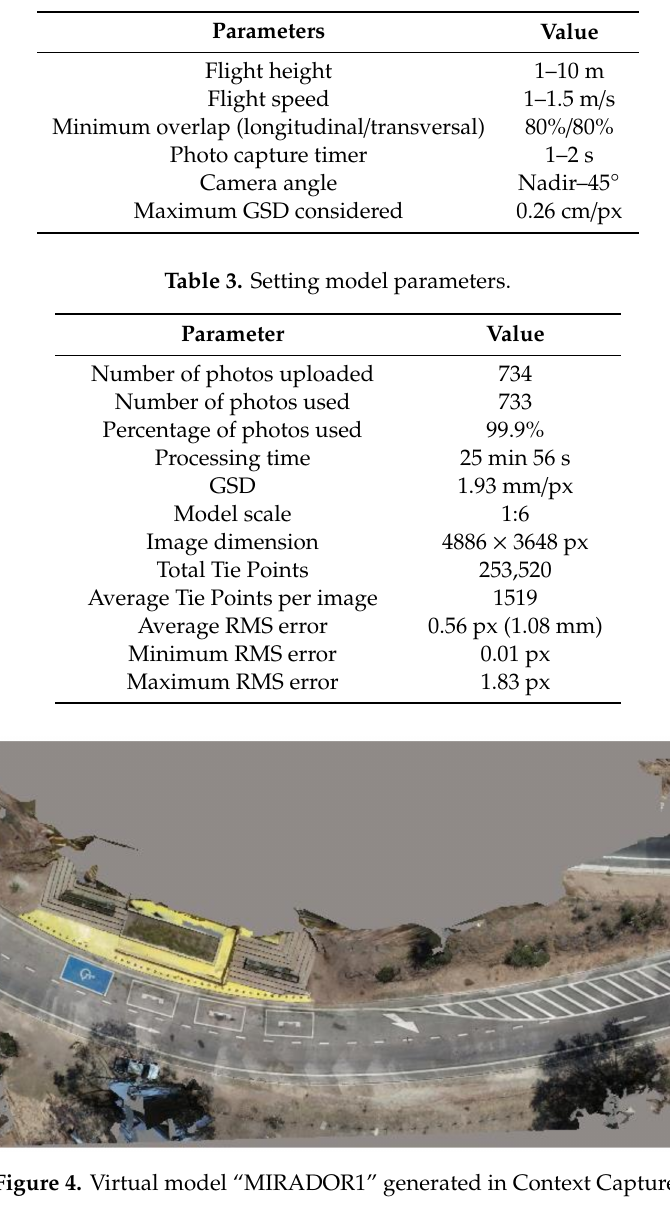
Table 2. UAV—Flight parameters.